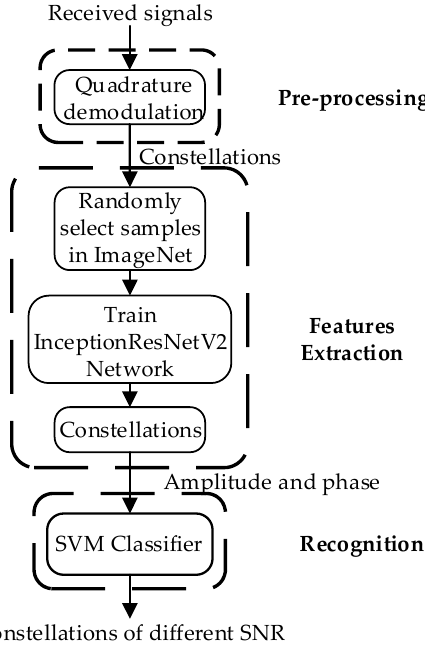
Figure 1. The block diagram of InceptionResnetV2-TA Algorithm.